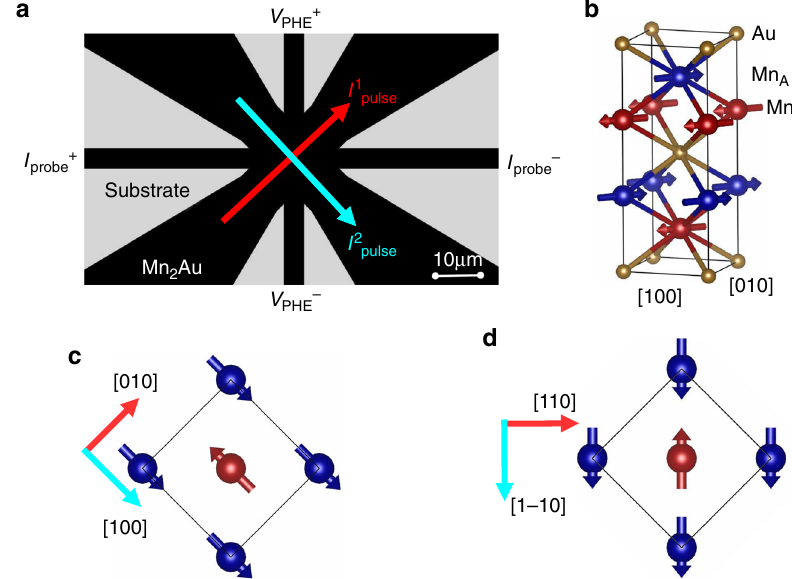
and probing pulse